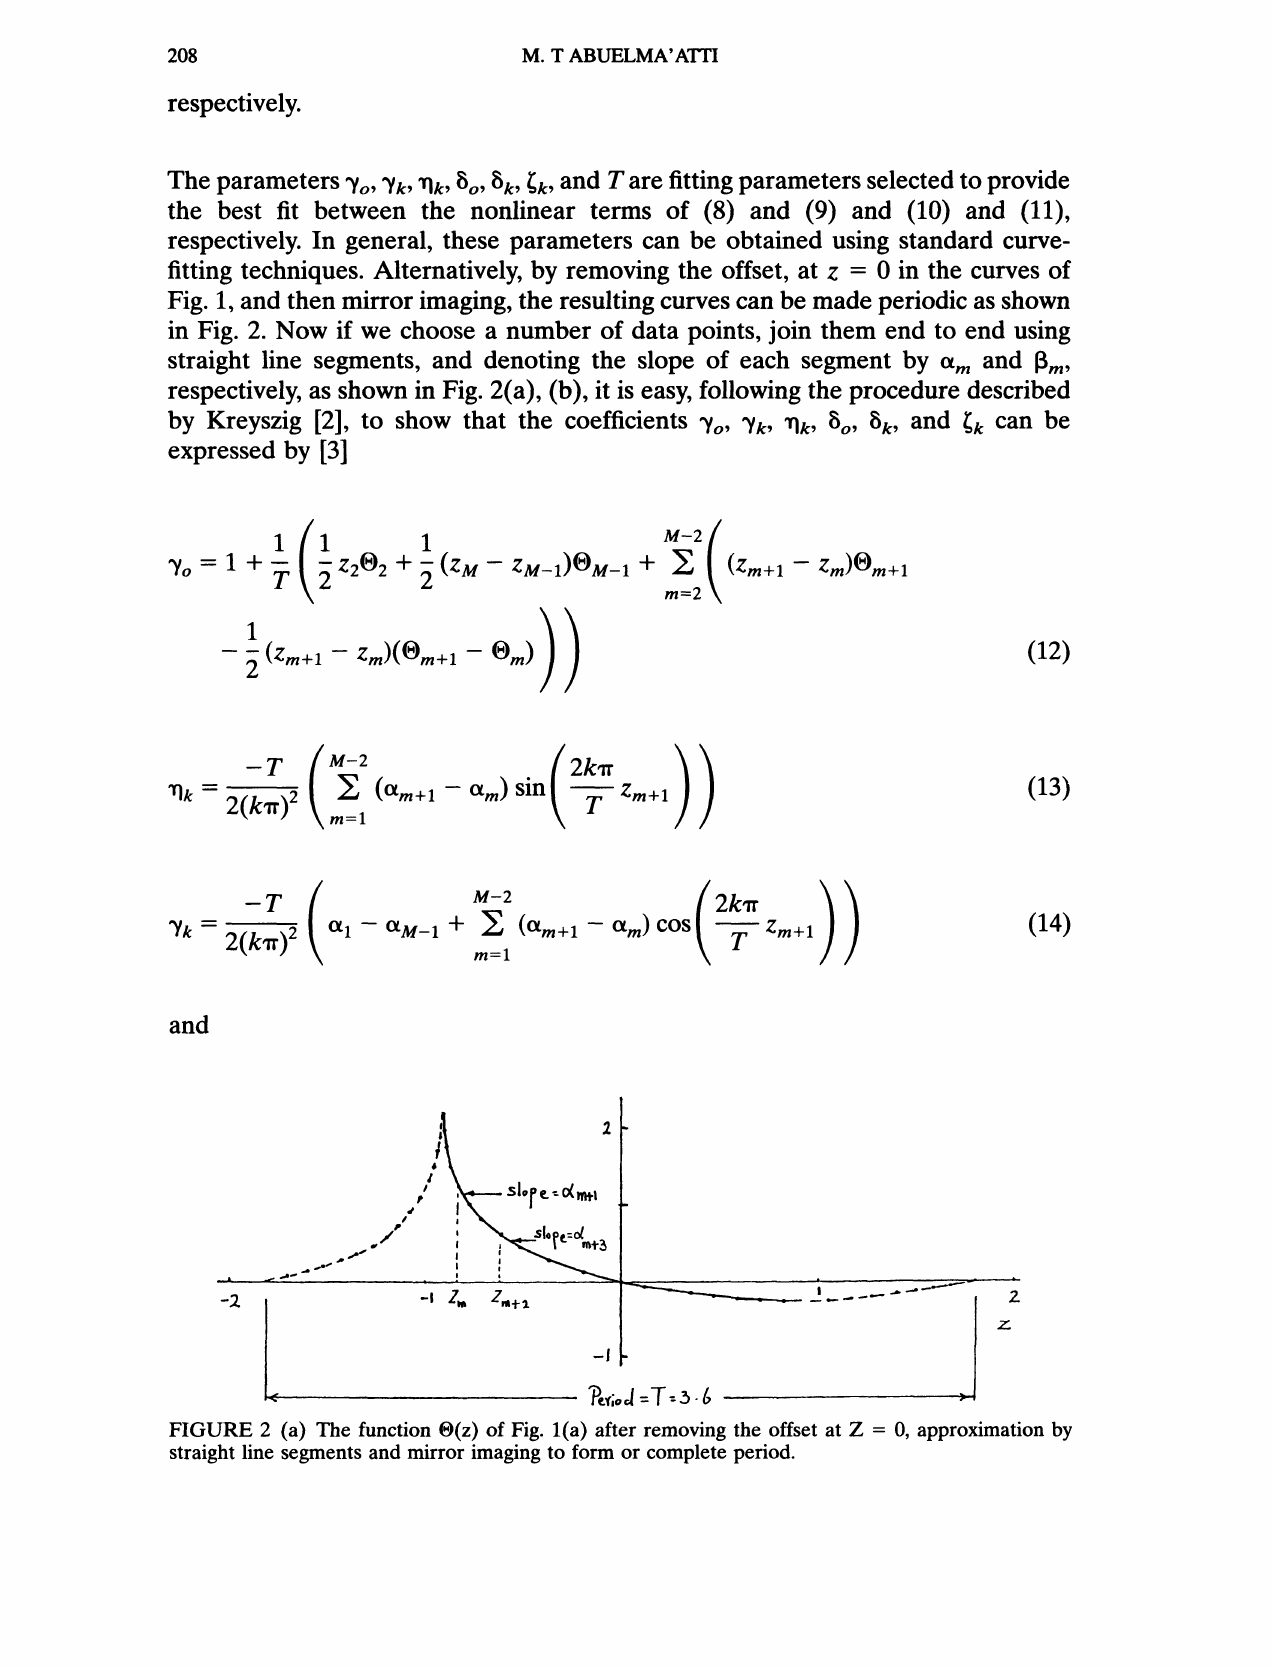
FIGURE 2 (a) The function O(z) of Fig. l(a) after removing the offset at Z 0, approximation by straight line segments and mirror imaging to form or complete